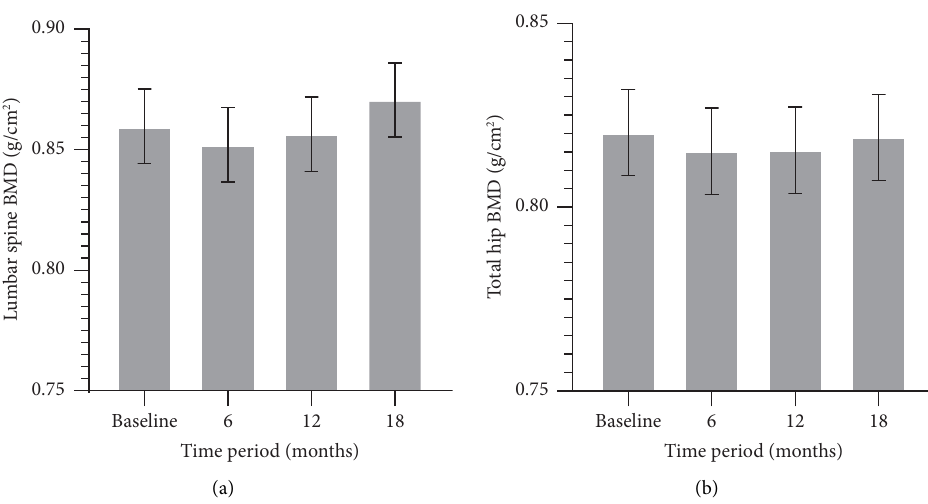
Figure 2: BMD changes over the 18-month treatment period. (a) Lumbar spine BMD; (b) total hip BMD. Te results are presented as the mean ± SE.